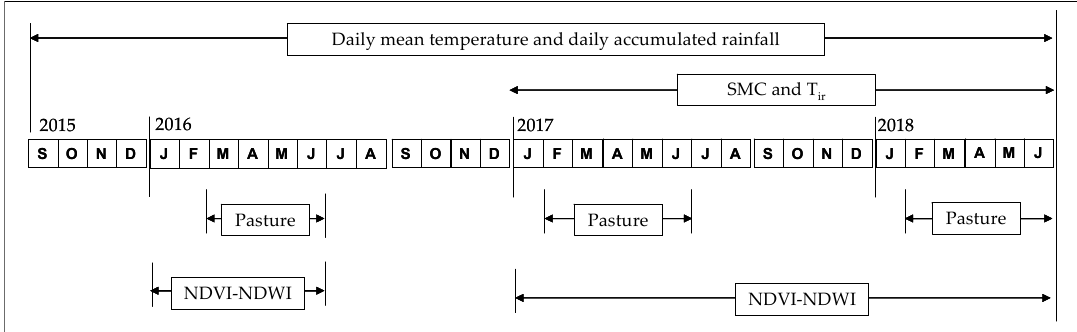
Figure 1. Chronological diagram of data acquisition of daily mean temperature, daily accumulated rainfall, soil moisture content (SMC), pasture surface temperature (T ir ), pasture productivity and quality, normalized difference vegetation index (NDVI) and normalized difference water index (NDWI) Sentinel-2 satellite-based.